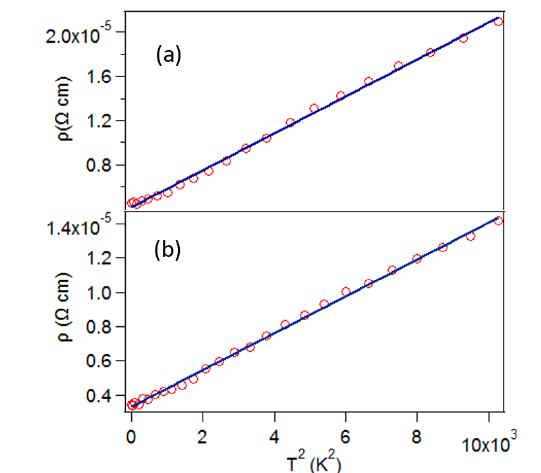
Figure 5. T 2 power law fit of low temperature resistivity of ( a ) NbP and ( b ) TaP